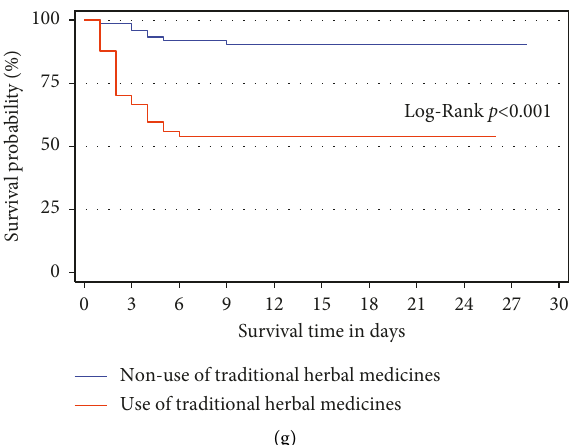
Figure 2: Kaplan–Meier analysis showing the probability of survival in AKI stage 3 patients up to 30 days according to: (a) age; (b) presence of anemia; (c) presence of coma; (d) presence of respiratory distress; (e) presence of hyperkalemia; (f) presence of HIV infection; (g) use of traditional herbal